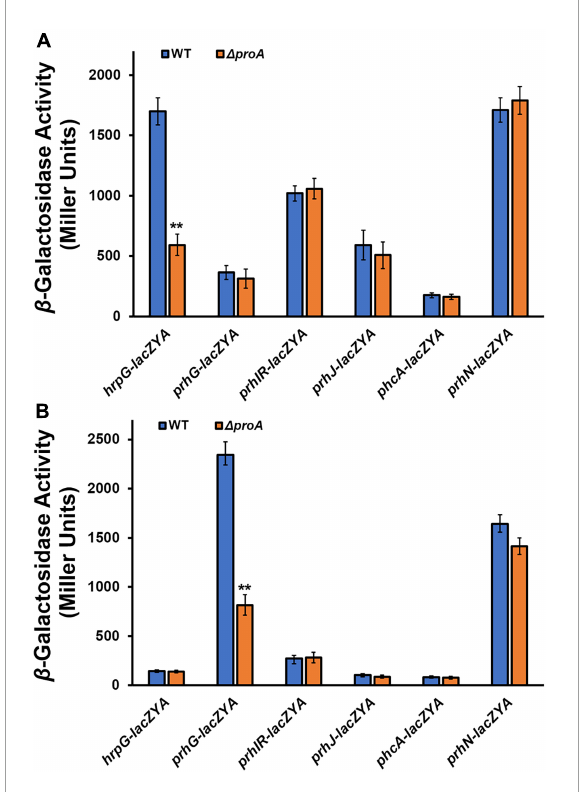
FIGURE3 Involvement of ProA in the expression of T3SS-regulated genes in (A) rich medium and (B) in hrp -inducing minimal medium with supplementary proline (50 mM). Wild type (WT) refers to each reporter strain of RK5120 ( hrpG-lacZAY ), RK5212 ( prhG-lacZAY ), RK5619 ( prhN-lacZAY ), RQ6144 ( prhIR-laczYA ), RQ6074 ( prhJ-lacZYA ), and RK5043 ( phcA-lacZAY ). (cid:49) proA refers to the deletion of proA from each reporter strain. Enzymatic activities were assessed with the in vitro enzyme assay and presented in Miller Units. Each assay was repeated with three biological replicates, including three replicates per trial. Mean values of all experiments were averaged with SD, and statistical significance between the wild-type strains and mutants was assessed using a post-hoc Dunnett test following ANOVA. Significance level, ** indicates P <